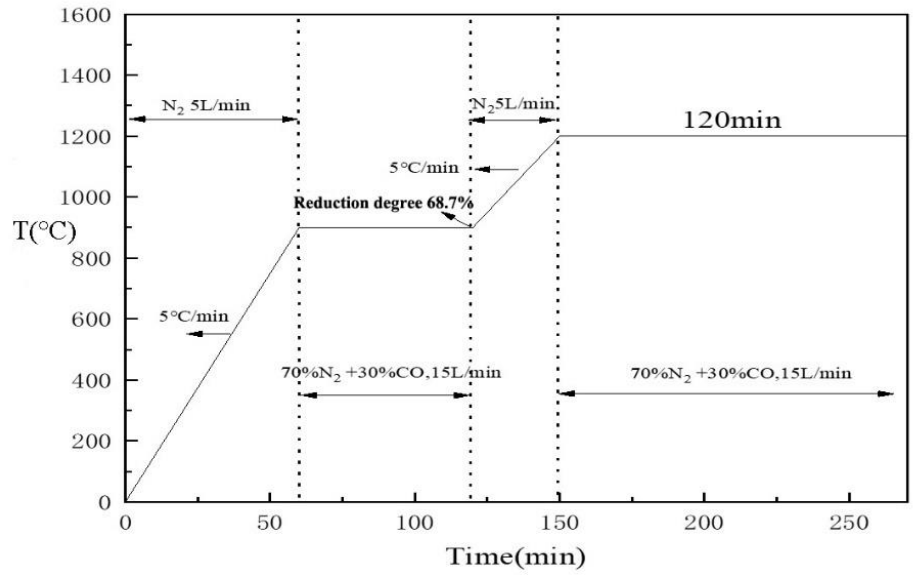
Figure 2. Temperature profile of the experiment.